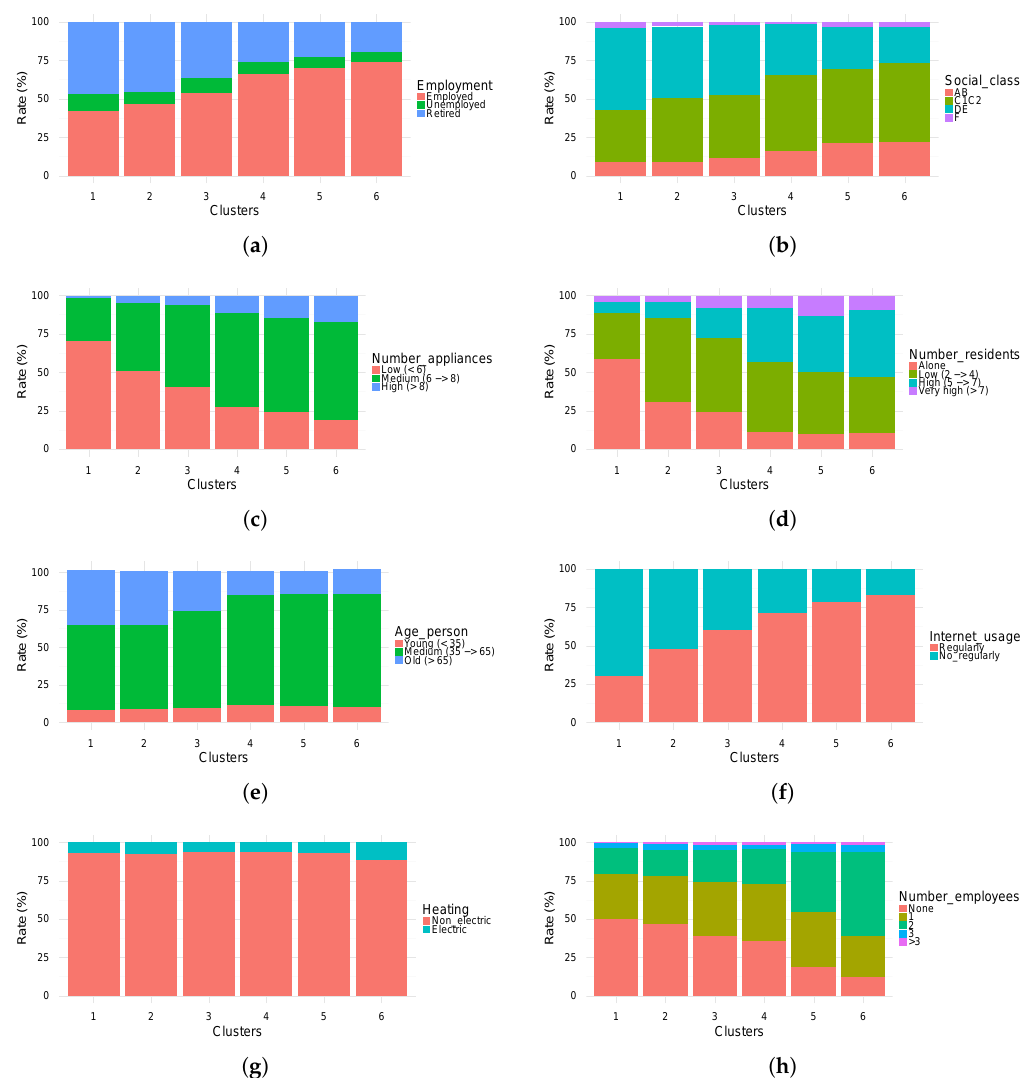
Figure 5. ( a ) representation of clusters according to employment, ( b ) social class (AB: managerial; C1C2: intermediate background; DE: manual background; F: farmer), ( c ) number of appliances, ( d ) household size, ( e ) age of the chief income earner, ( f ) Internet usage, ( g ) heating and ( h ) number of